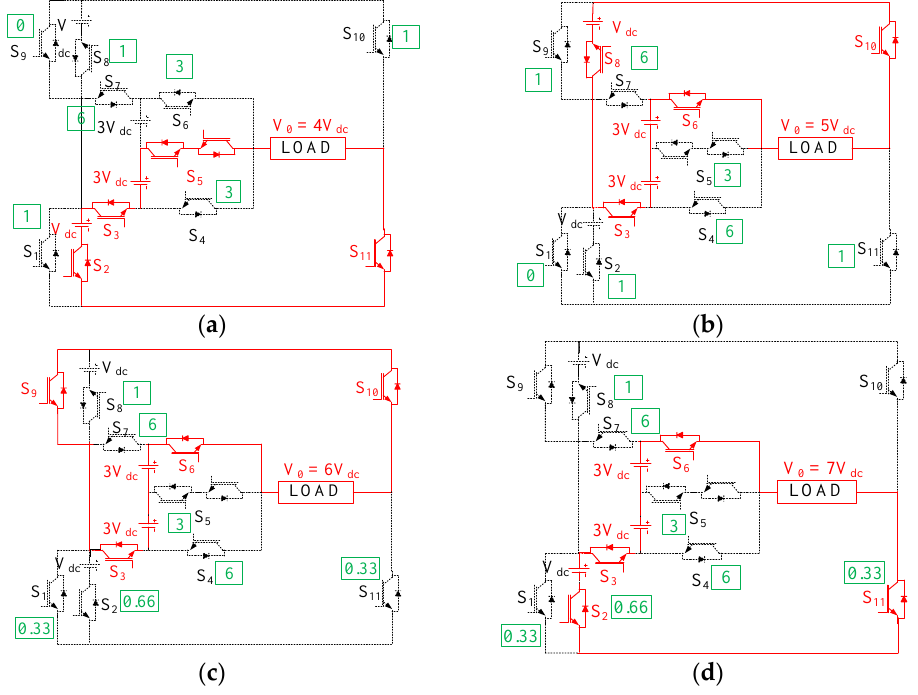
Figure 3. Positive conduction states (part 2). ( a ) State 4 ( b ) State 5 ( c ) State 6 ( d ) State 7.